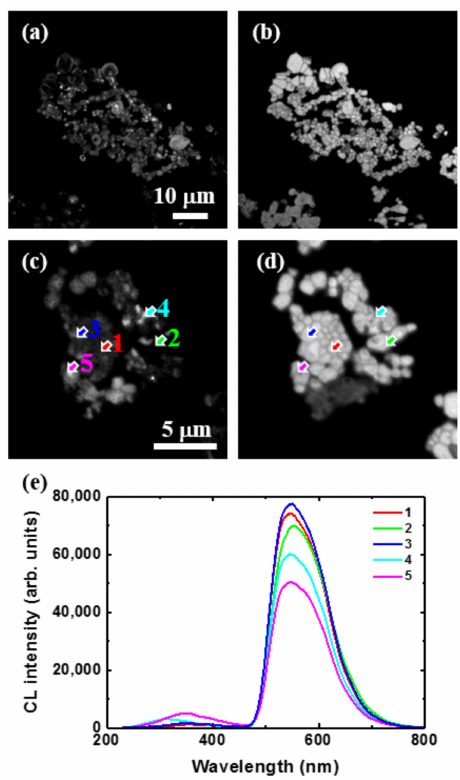
Figure 9. Cross-sectional CL images taken at 330 and 540 nm for C@YAG:Ce 3+ -1650 ◦ C at × 2000 ( a , b ) and × 7000 ( c , d ) magnifications, respectively; ( e ) and, Local CL spectra taken on locations indicated by arrows in the